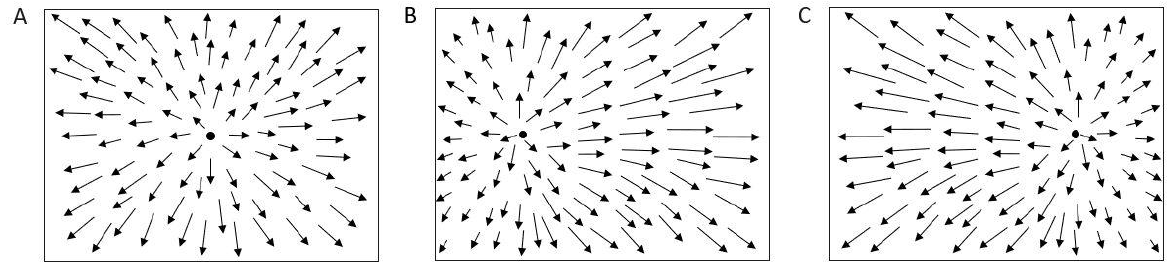
Figure 2. Schematic drawing of optic flow fields. Arrows represents the direction of moving elements presented in the visual field. The dot represents the focus of expansion (FOE). A. Optic flow representing forward motion in which the observer moves straight ahead. B. Optic flow representing forward motion to the left. C. Optic flow representing forward motion to the